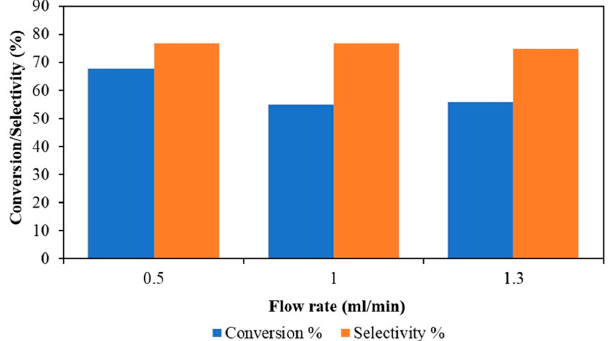
Figure 12. Effect of the flow rate at a different speed of agitation for three phases. Epichlorohydrin 0.1 mol, n-decane 0.03 mol, toluene 150 cm 3 , guaiacol 0.1 mol, sodium hydroxide 0.2 mol, sodium chloride 0.6 mol, tetra-n-butylammonium bromide 0.14 mol, and water 150 cm 3 , temperature 40 °C, speed of agitation of lower aqueous phase 25 rpm, speed of agitation of middle catalyst phase 80 rpm, speed of agitation of upper organic phase 60 rpm, and reaction time 6